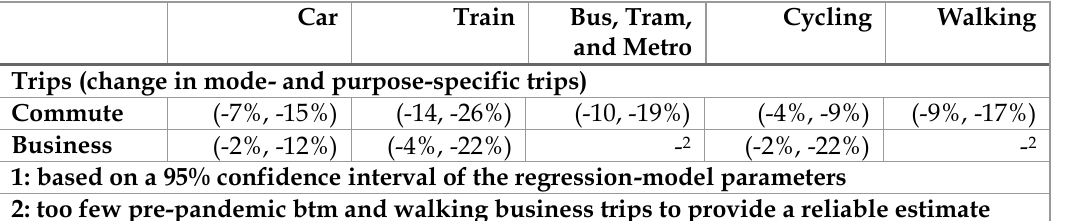
Expected range of changes1 in commuting and business trips due to working from home and teleconferencing per mode (Results based on MPN questionnaire and travel diary) Car Train Bus, Tram, Cycling and Metro